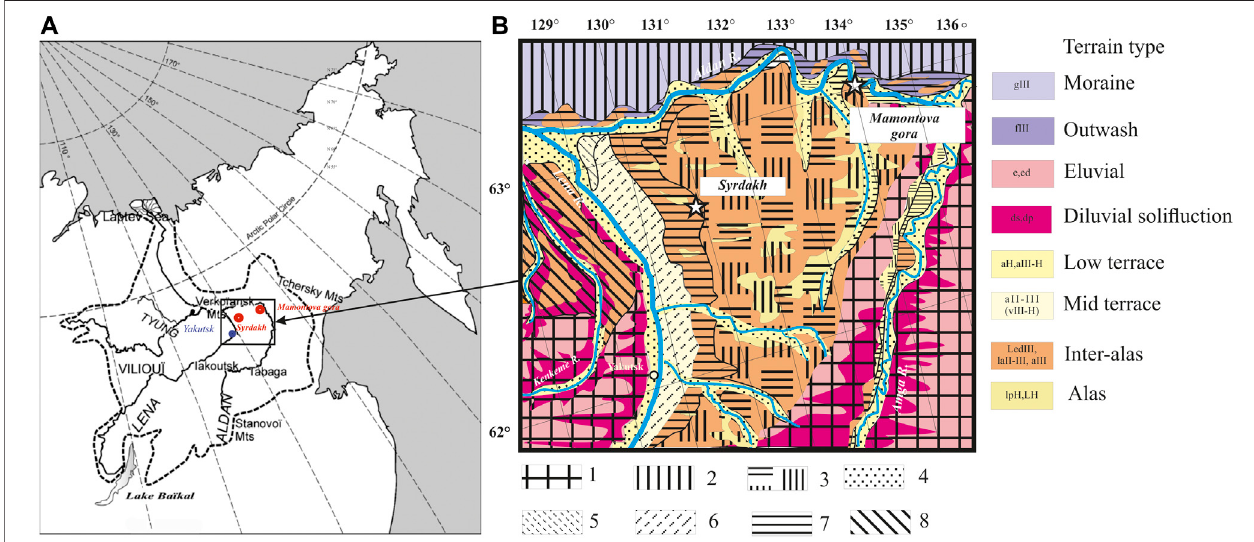
FIGURE1| Locationofthestudysites (A) Studyregion (B) Schematicgeomorphological mapoftheLena-Aldaninter fl uvewithmaingenetictypesofdepositsand corresponding terrains (based on Ivanov, 1984, Solovev, 1959; Pravkin et al., 2018; Fedorov et al., 2018). Legend: the types of terrain are indicated by color, geomorphological levels by hatching: 1) denudation plain, 2) glacial- fl uvioglacial plain, 3) erosion-accumulative Abalakh plain, 4) low terraces of Lena and Aldan, 5) Kerdem terrace (III), 6) Bestyakhskaya terrace (IV), 7) Tyungyulun terrace (V), 8) Magan terrace.